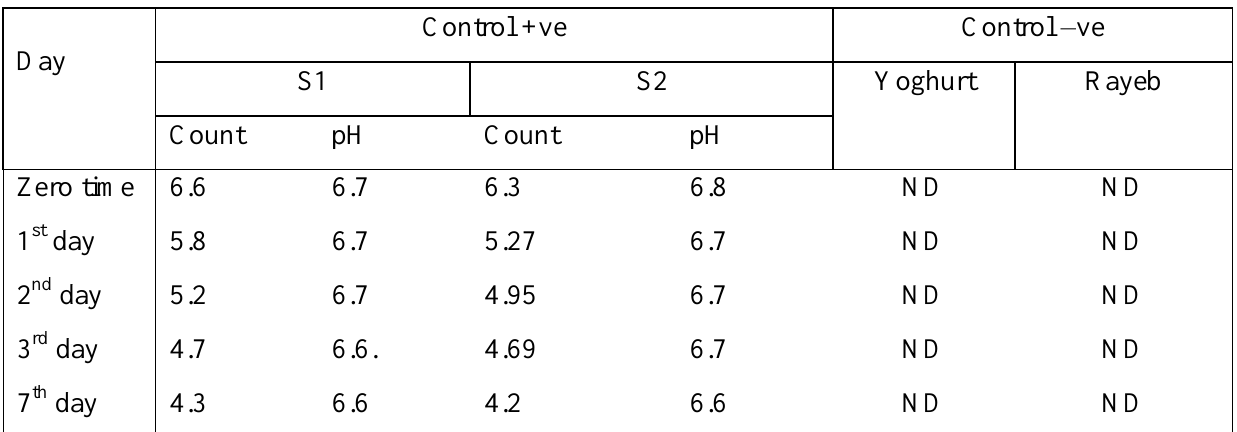
Table 6: Results of control